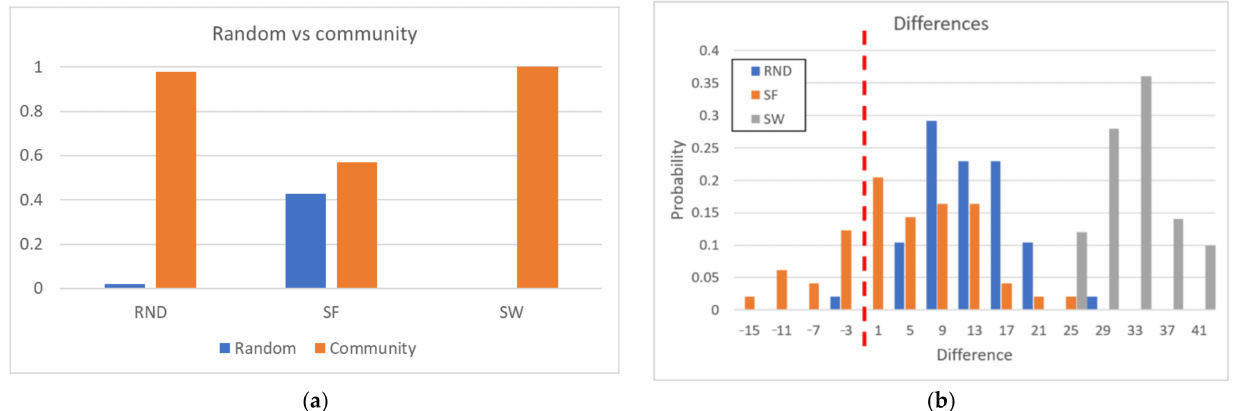
Figure 3. Effects of partitioning the system based on network analysis. ( a ) Fraction of times (over 50 runs) in which the minimum number of candidate RSs by using the s-partitioning is lower than the number of candidate RSs of the graph partitioning (blue), vs. the fraction of times that the number of candidate RSs of the graph partitioning is smaller (orange). ( b ) The distribution of the difference between the minimum number of candidate RSs of the s-partitioning and the number of candidate RSs of the graph partitioning in RND, SF and SW cases. This difference is almost always positive (sometimes by far positive), indicating the adherence of the community algorithm to the dynamic characteristics of the system under examination. Note that fewer candidate RSs to analyze results in a much faster final